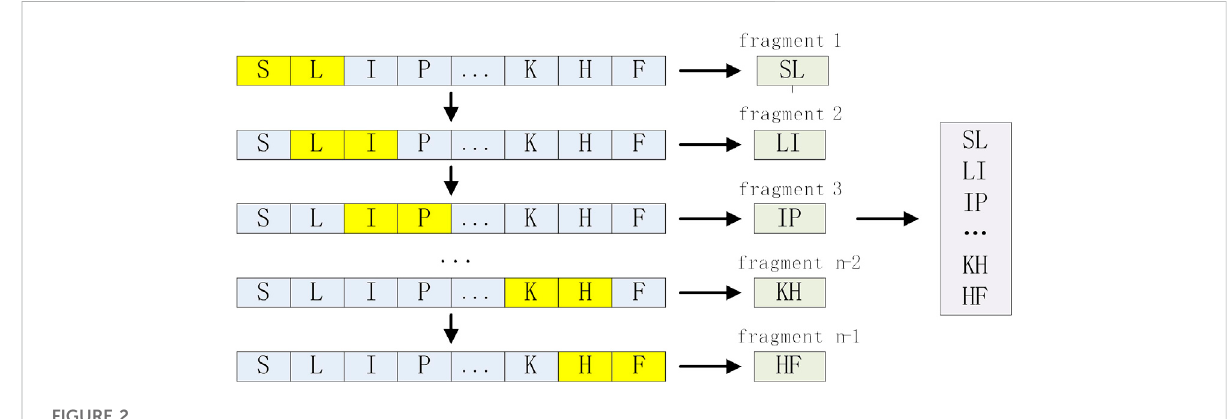
FIGURE 2 Bi-gram encoding